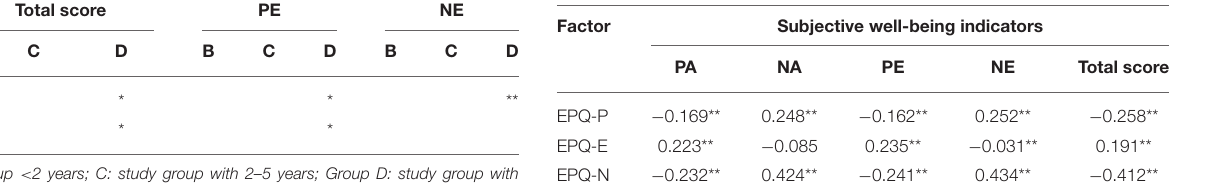
TABLE 7 | Correlation analysis between personality factors and subjective well-being score of the elderly. Factor